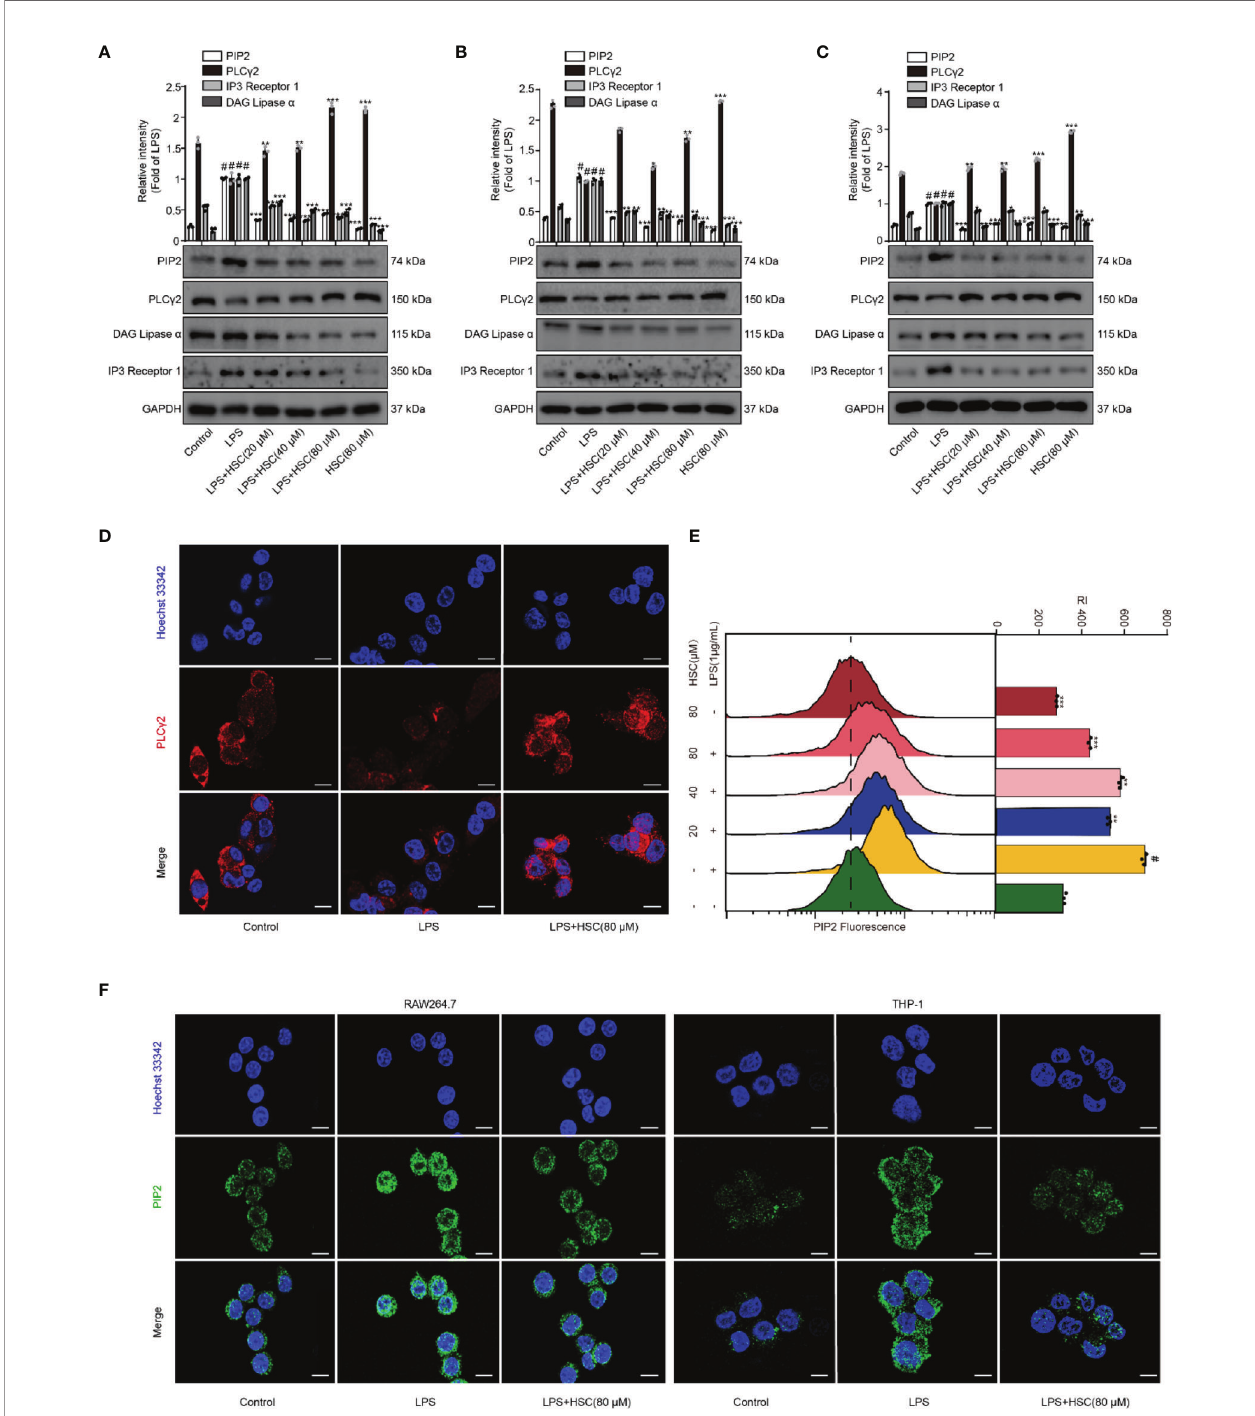
FIGURE 5 | Effect of HSC on the PIP2 signaling pathway. (A) RAW264.7, J774A.1, THP-1 cells treated with HSC for 4 h, and then induced by LPS (1 m g/ml) for 1 h; (A, B, and C) The expression of PIP2, PLC g 2, DAG, and IP3 were detected by western blotting in RAW264.7 (A) , J774A.1 (B) , THP-1 (C) cells; (D) The PLC g 2 expression was detected by immuno fl uorescence assay in RAW264.7 cells; (E) Detection of PIP2 expression in RAW264.7 cells by fl ow cytometry; (F) Detection of PIP2 expression by immuno fl uorescence in RAW264.7 and THP-1 cells (Scale bar=20 m m); # P < 0.001 compared to control alone group; * P < 0.05, ** P < 0.01, and *** P < 0.001, versus the LPS group,